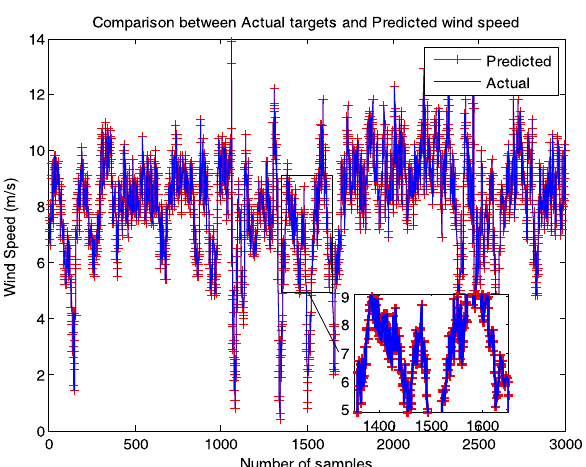
Fig. 2 Comparison between actual and predicted wind speed